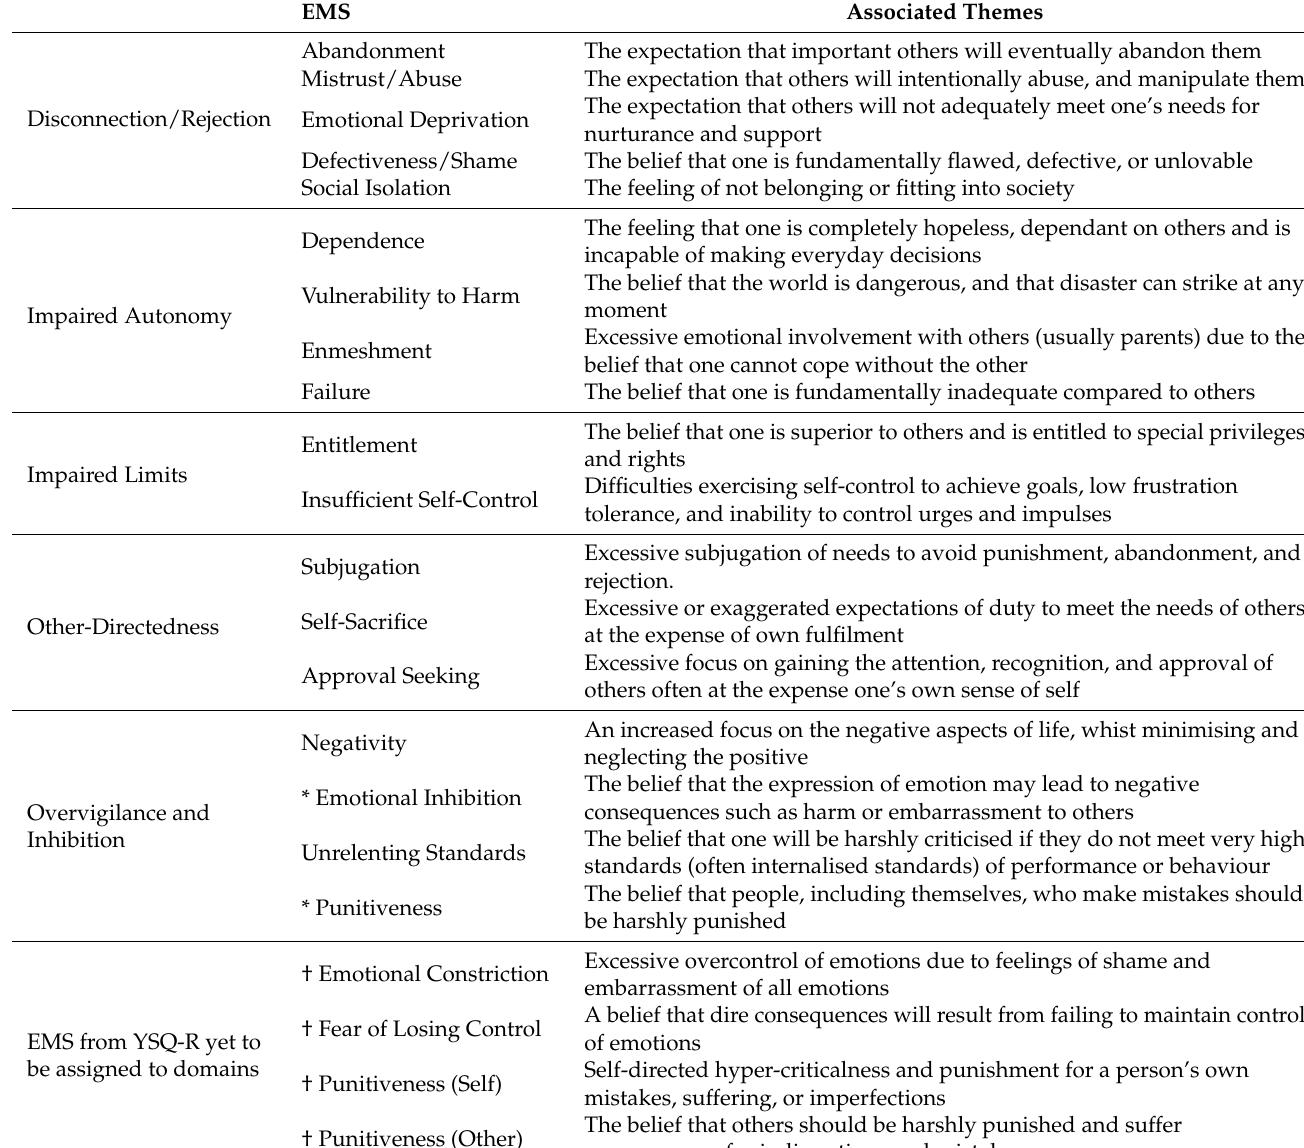
Table 1. Eighteen Early Maladaptive Schemas (EMS) and Associated Themes as Proposed by Young et al.